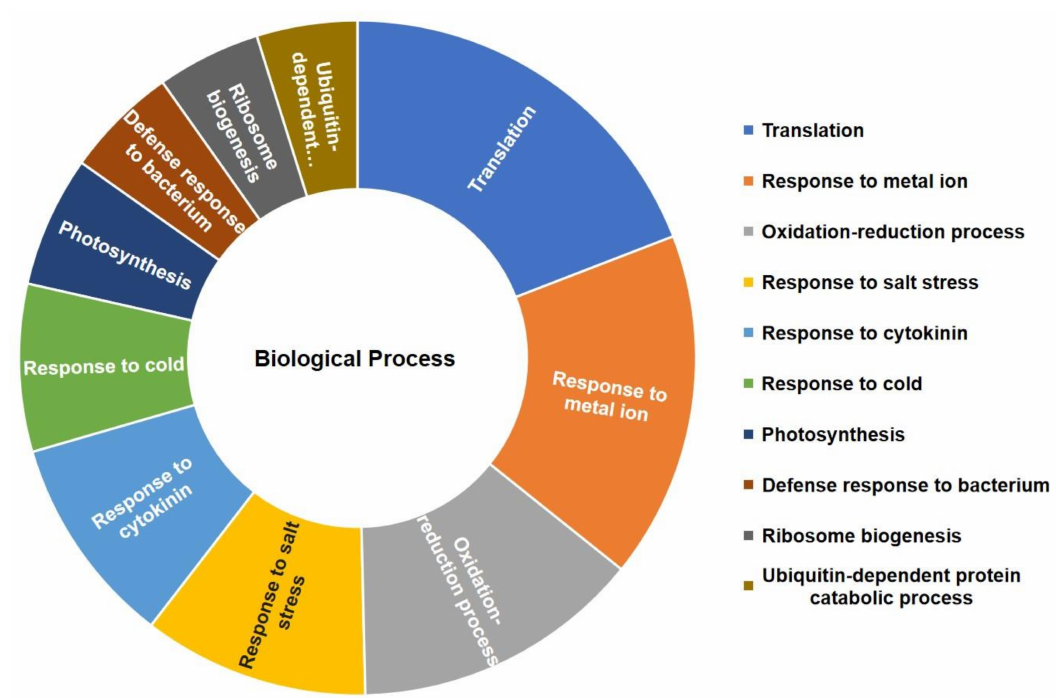
Figure 5. Gene ontology (GO) annotation (biological process) of the total identified proteins in B. napus seedlings in response to CA-mediated Cu stress using DAVID